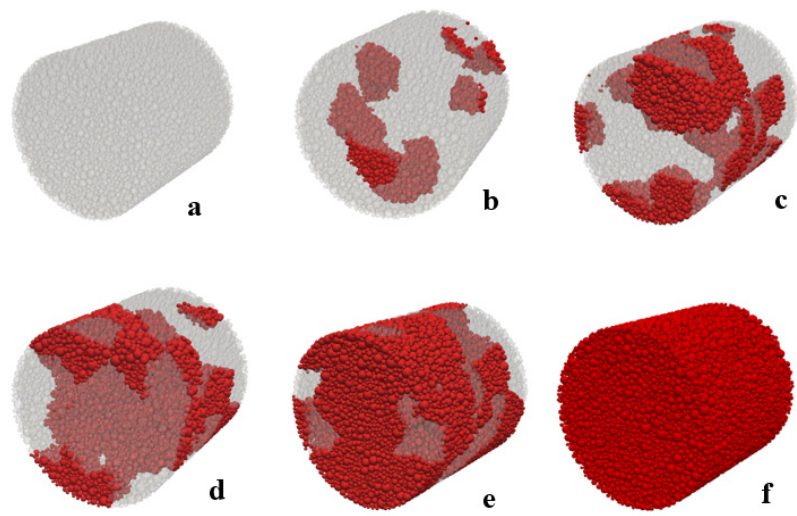
Figure 8. Typical mineral grades of rock specimen. ( a ) 0%, ( b ) 10%, ( c ) 25%, ( d ) 50%, ( e ) 75% and ( f ) 100% grade composition.